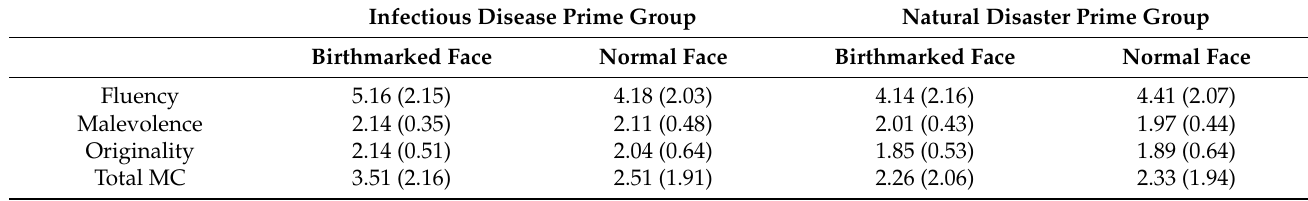
Table 2. Means and standard deviations of MC in Study